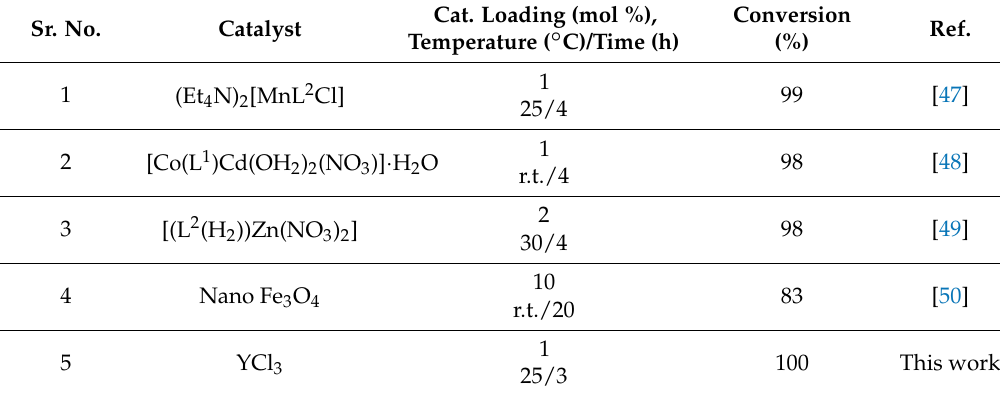
Table 3. Data regarding the solvent-free aminolysis of styrene oxide ( 1a ) with aniline ( 2a ). Sr.